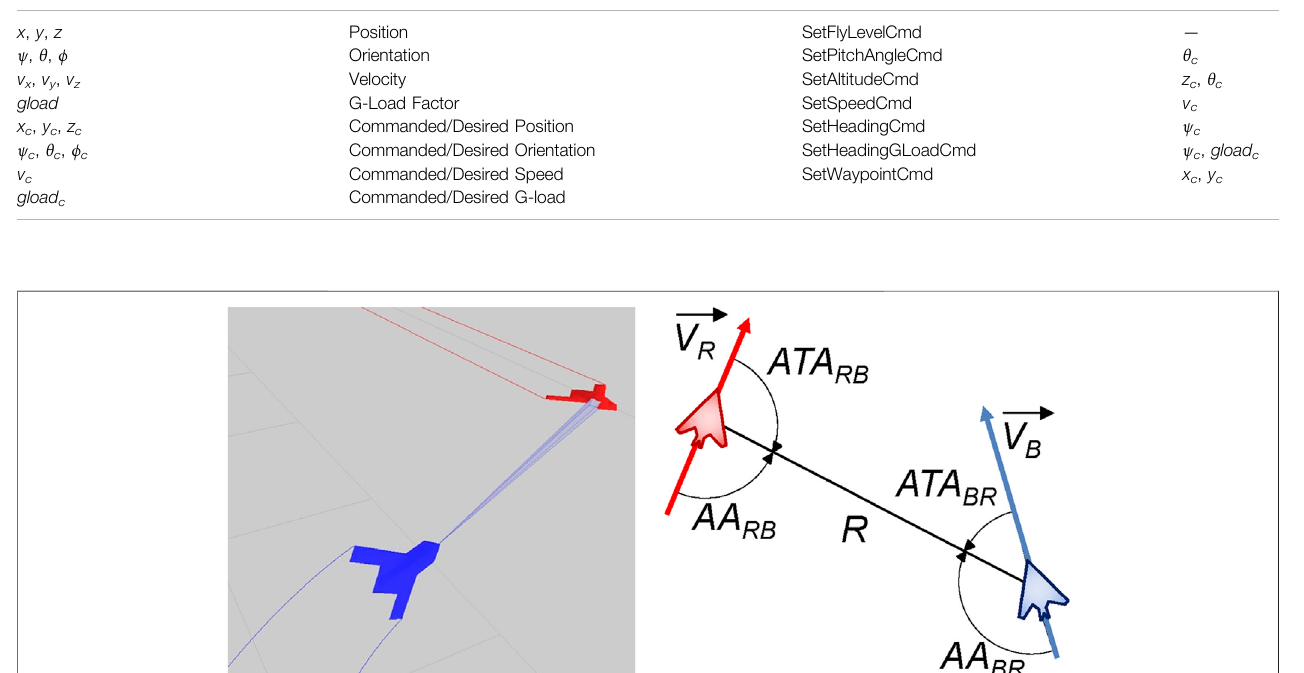
TABLE 1 | An overview of the input state variables (left) and the commands available to control the simulated UAV in ACE0. State Variables